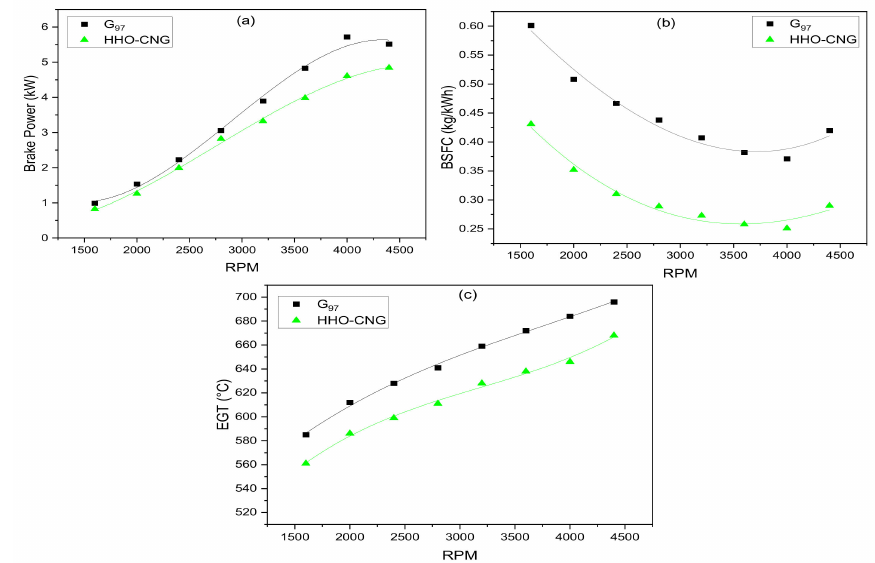
Figure 2. ( a ) BP, ( b ) BSFC, and ( c ) EGT for gasoline and